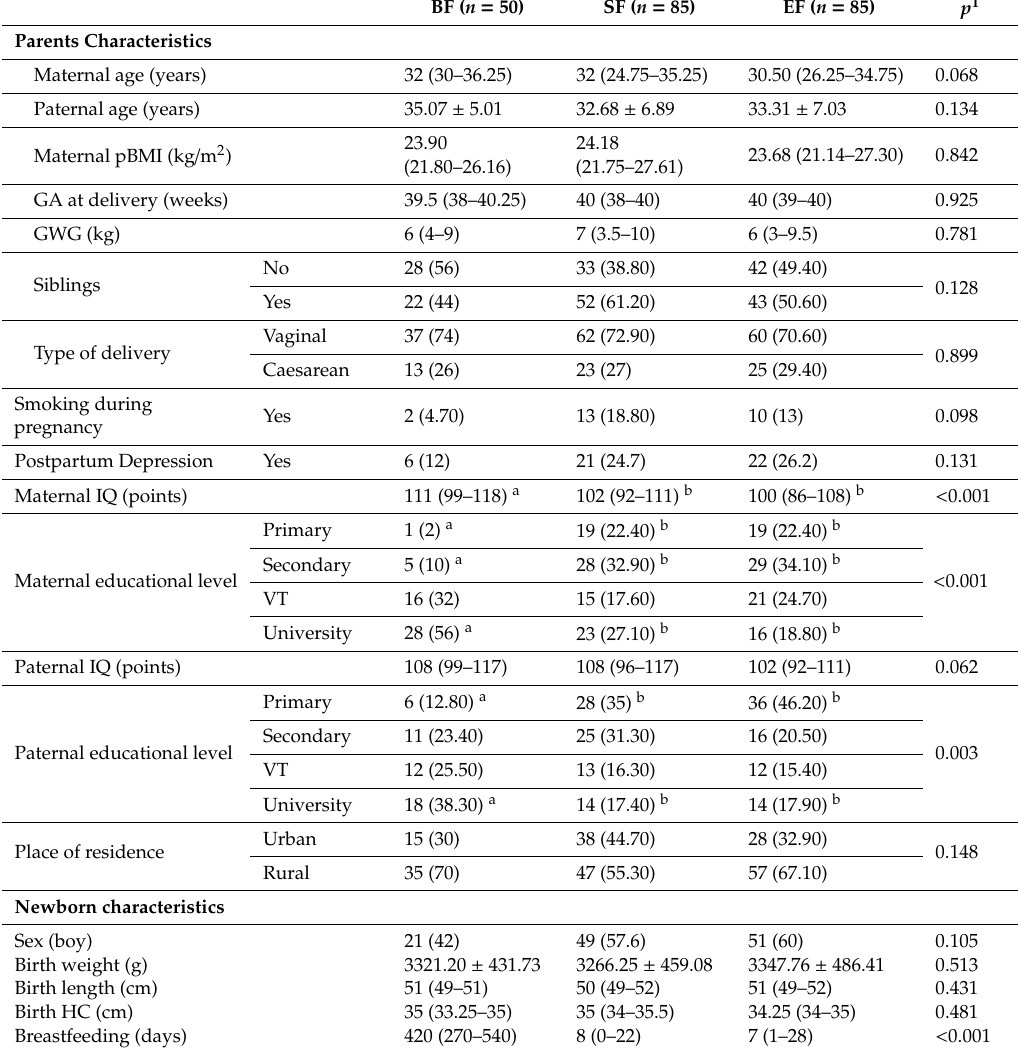
Table 2. Characteristics of the COGNIS study